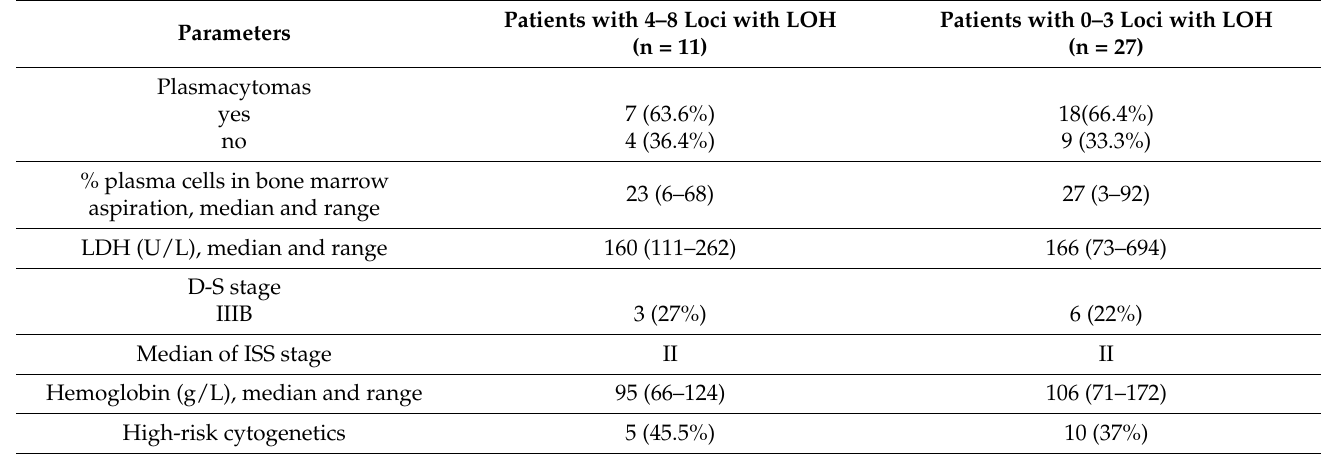
Table 5. Clinical and laboratory parameters in patients with different LOH frequencies.